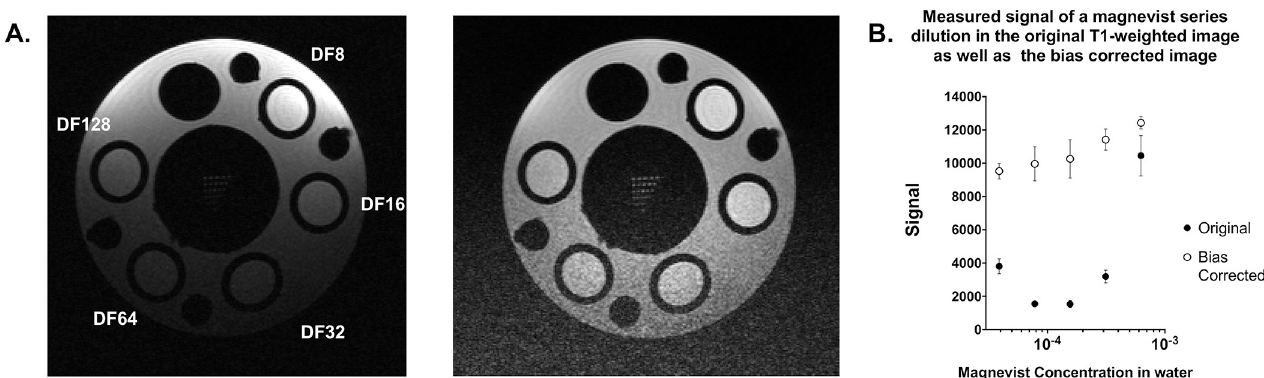
Fig 5. Correction of position-dependent bias resulting from use of the surface coil. A custom phantom containing concentrations of magnevist with T1 values that span those anticipated in tumors were scanned using the surface coil. T1-weighted imaging of the phantom demonstrated a significant bias (A, left), which distorted the intensity of the magnevist tubes due to distance from the coil. Resulting measurements were unable to reflect the concentration-dependent signal appropriately (B). Application of an N4ITK bias correction, masked with a proton density weighted image (TR = 3000) reduced the effects of the coil bias (A, right), restoring linearity in the signal vs concentration curve